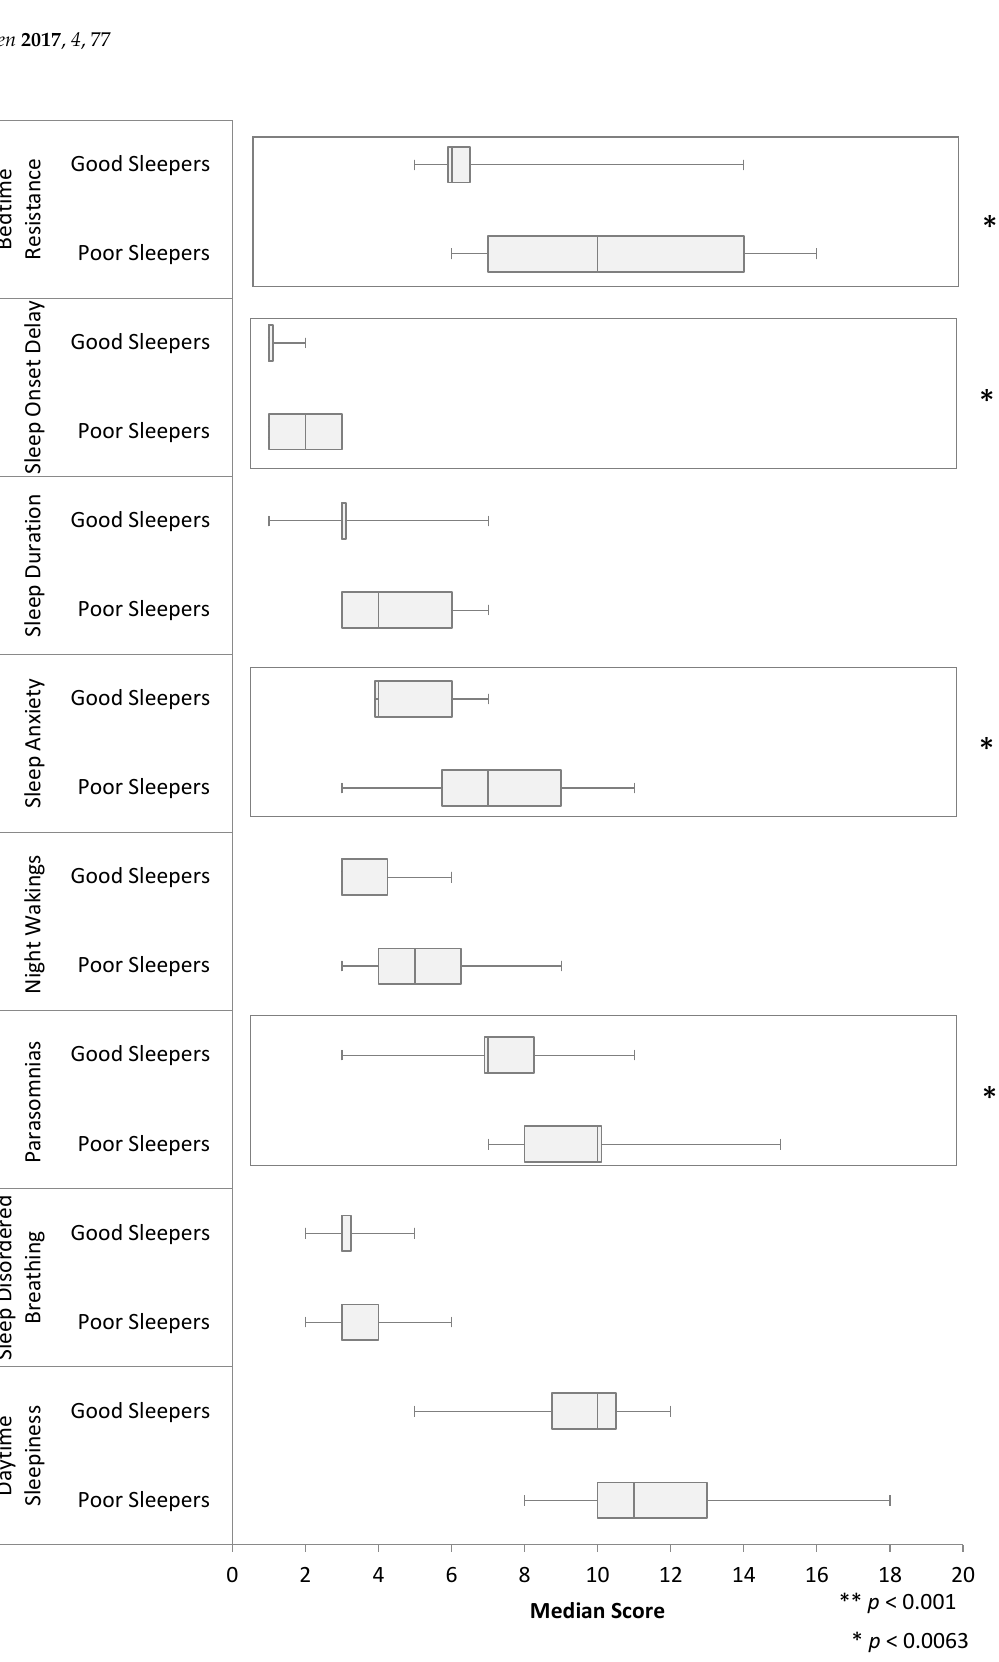
Figure 1. Boxplot of the Children’s Sleep Habits Questionnaire (CSHQ) scores showing the differences between good sleepers vs. poor sleepers in terms of median (vertical line), interquartile range (box where given) and whiskers to maximum and minimal values.